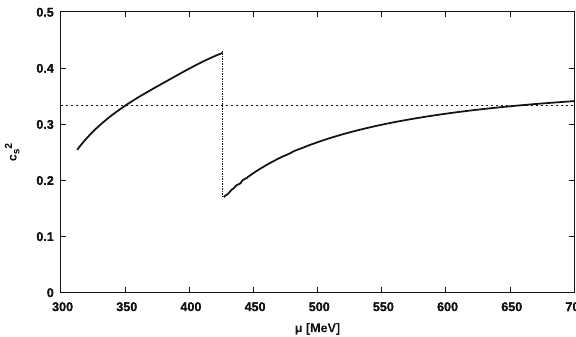
Fig. 13 Thephasediagramincludingnuclearmatter(blueregion)fora choiceofpotentialsfittedtolatticedata(potentials7a)andforparameter choices b = 10 and c b = 1. Figure taken from [274]